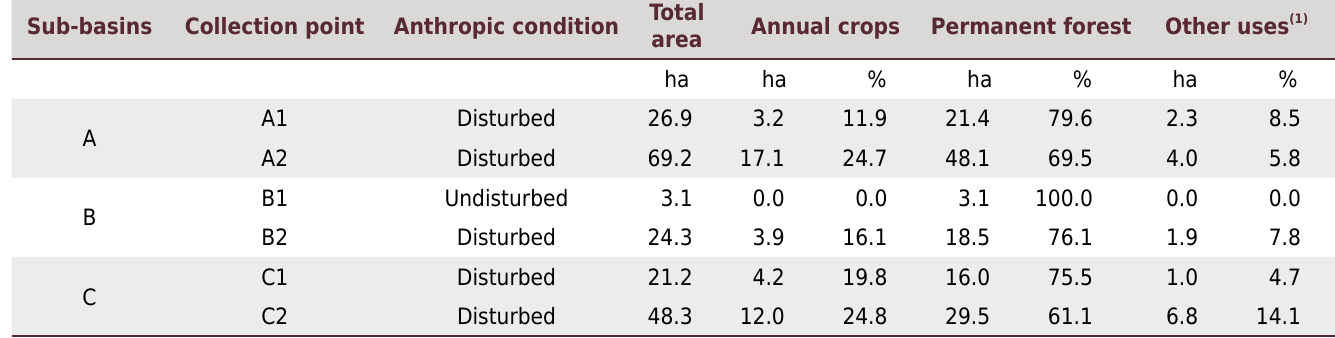
Table 1. Areas and relative contribution of the land uses at each point of the three sub-basins monitored in the Agudo catchment, Rio Grande do Sul, Brazil Sub-basins